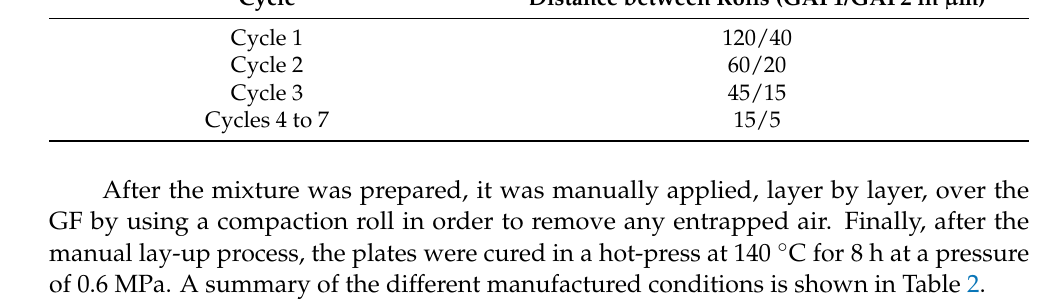
Table 1. Three roll-milling parameters. Cycle